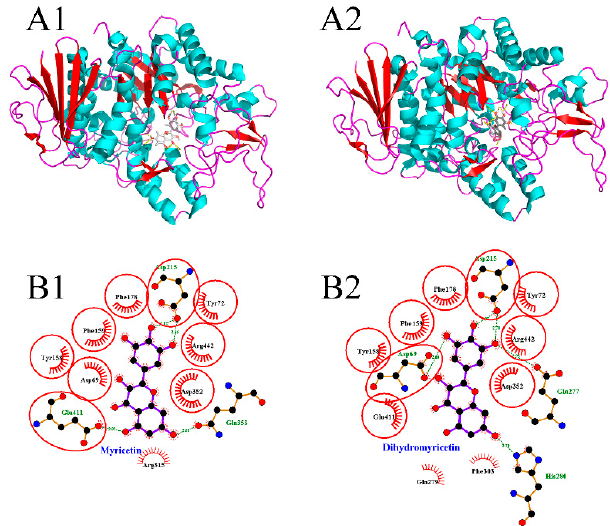
Figure 2. Molecular docking results of myricetin and dihydromyricetin with α -glucosidase (( A1 , A2 ) are the binding modes of myricetin and dihydromyricetin with α -glucosidase, respectively; ( B1 , B2 ) are the schematic diagrams of the interactions between myricetin and dihydromyricetin with α -glucosidase, respectively).